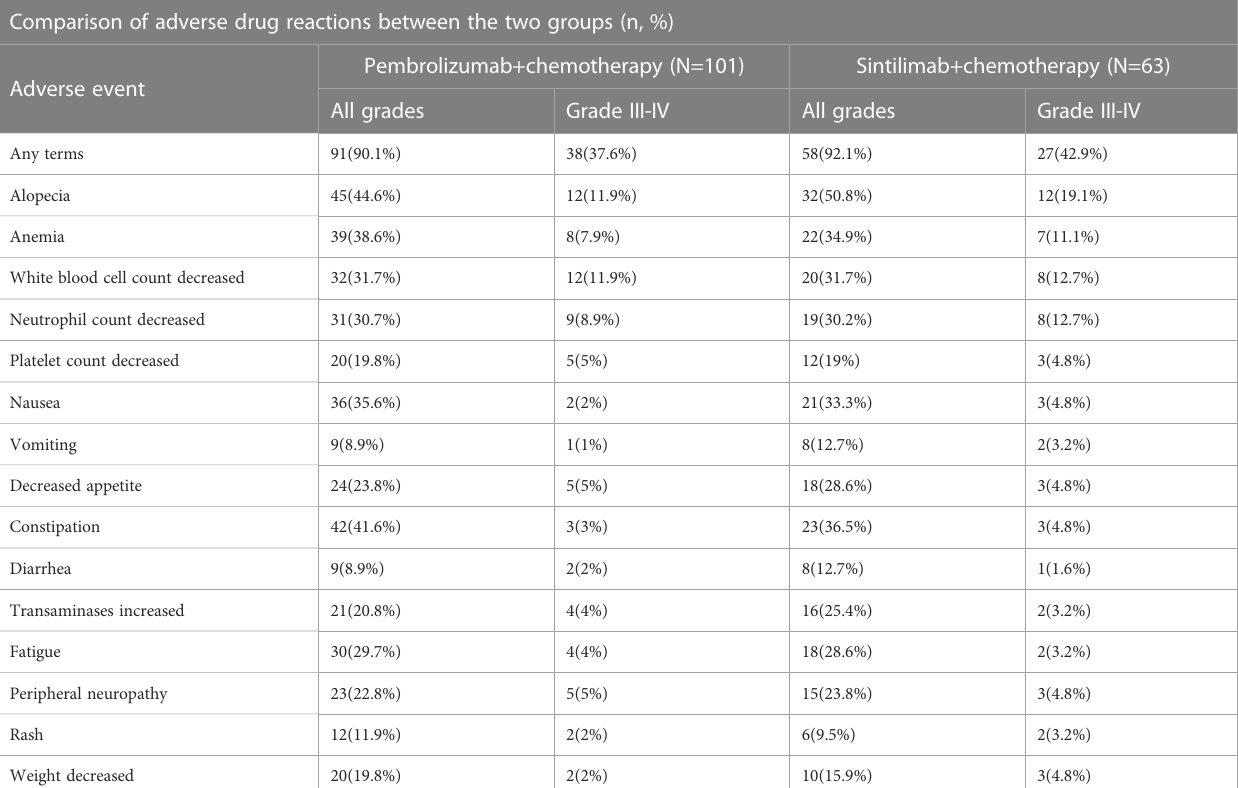
TABLE 3 Comparison of adverse events between the two groups. Comparison of adverse drug reactions between the two groups (n,